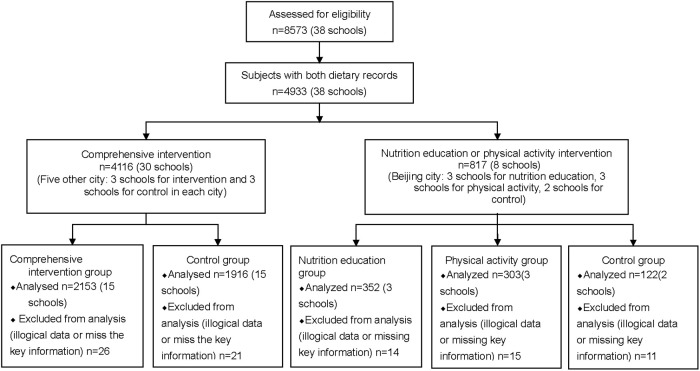
The trial profile for data analysis.